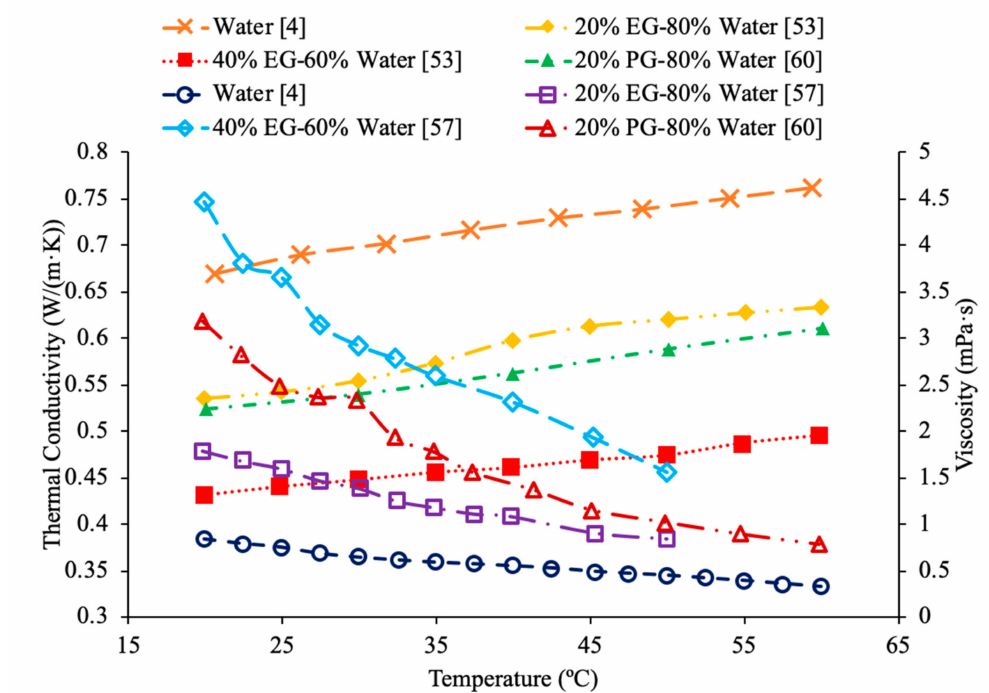
Figure 23. Thermal conductivity (increasing with temperature) and viscosity (decreasing with temperature) for Fe 3 O 4 nanofluids at 0.2% volume fraction in base fluids of water, water–ethylene glycol (EG), and water–propylene glycol (PG)